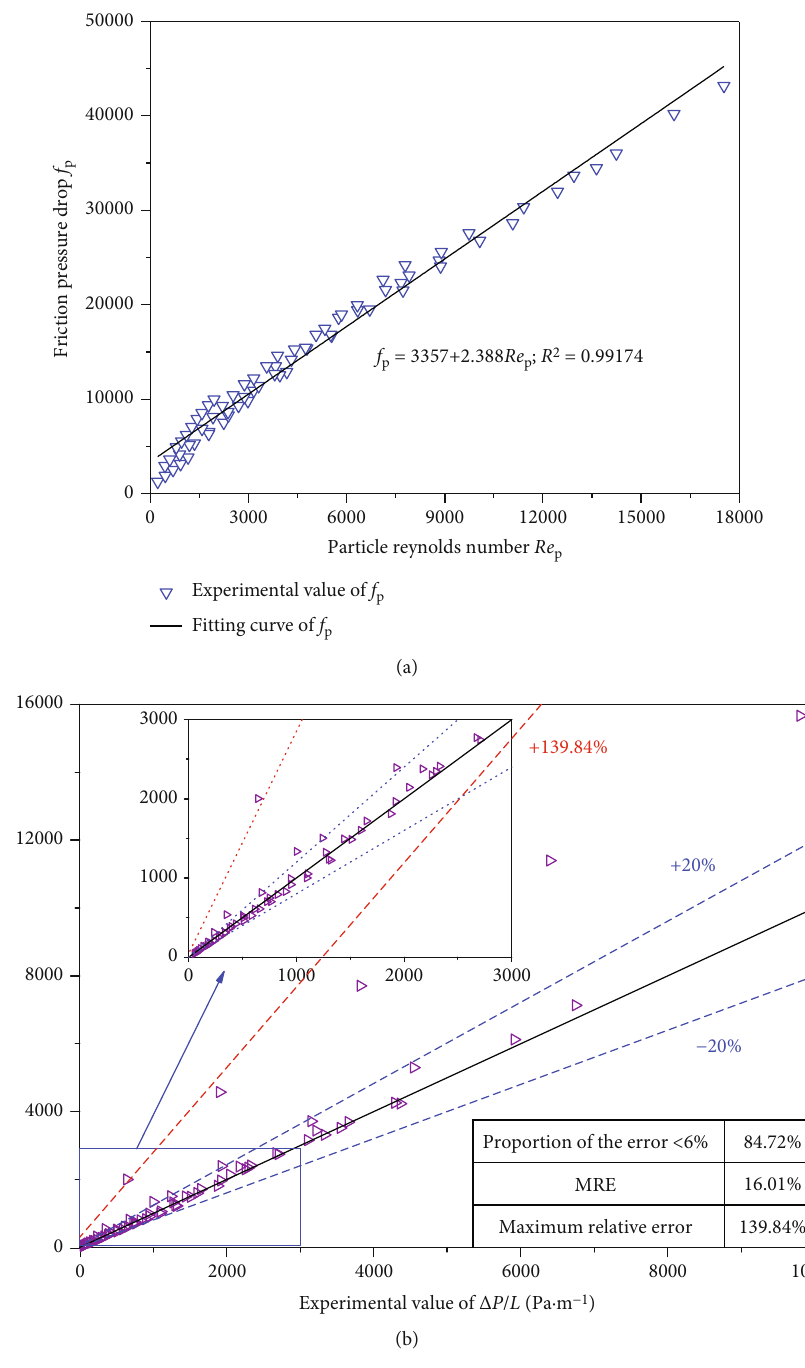
Figure 9: Analysis of the empirical correlation of the pressure drop without the wall correction: (a) relationship between f (b) comparison between the experimental value and the predicted value of Δ P / L